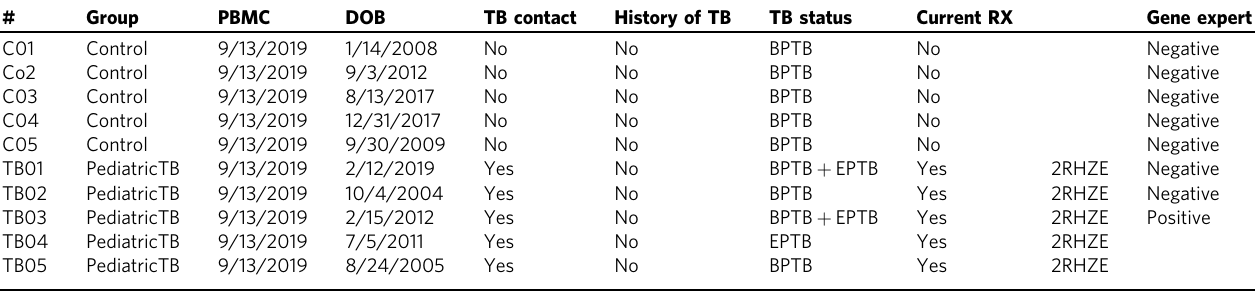
Table 1 Clinical classi fi cation of peripherl blood samples from children with tuberculosis and those exposed to tuberculosis. #